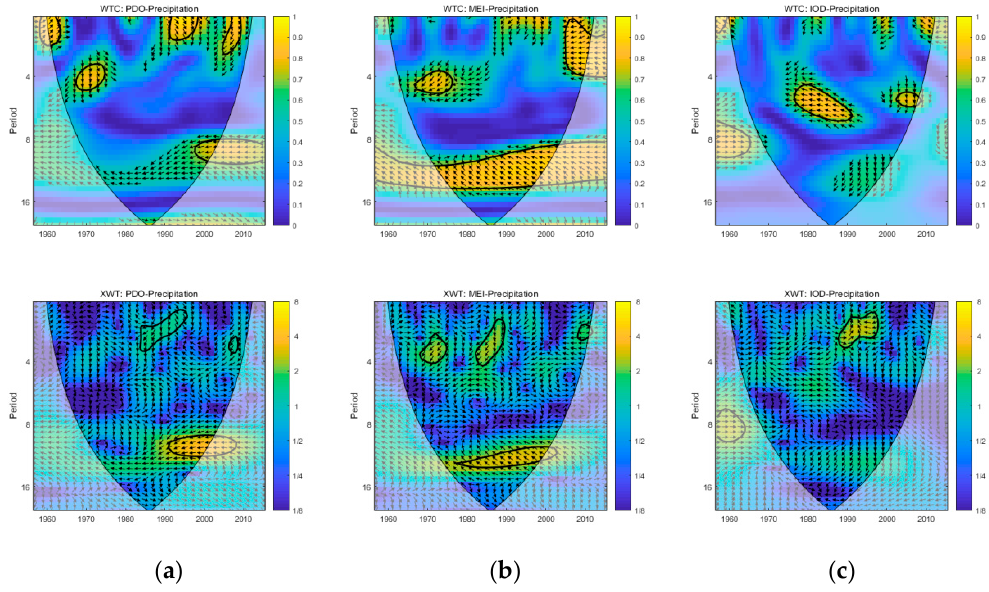
Figure 10. Wavelet coherence and cross wavelet transform of annual average precipitation with ( a ) PDO, ( b ) MEI, ( c ) IOD (1957–2015). The thick black contours depict the 5% significance level of local power, relative to red noise, and the black line is the cone of influence. Right-pointing arrows indicate that the two signals are in phase, while left-pointing arrows are for anti-phase signals. Up-pointing (down-pointing) arrows indicate that the precipitation change of the YLZR basin was ahead (backward) of the large-scale circulation indices and was 90°, which meant that the precipitation change of the YLZR basin was one quarter of a cycle earlier (later) than that of the large-scale circulation indices. The unit of the period is a.